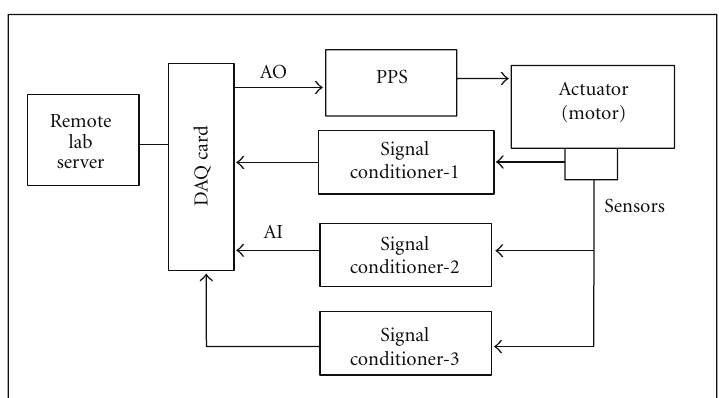
Figure 2: Hardware block diagram of remote experimental